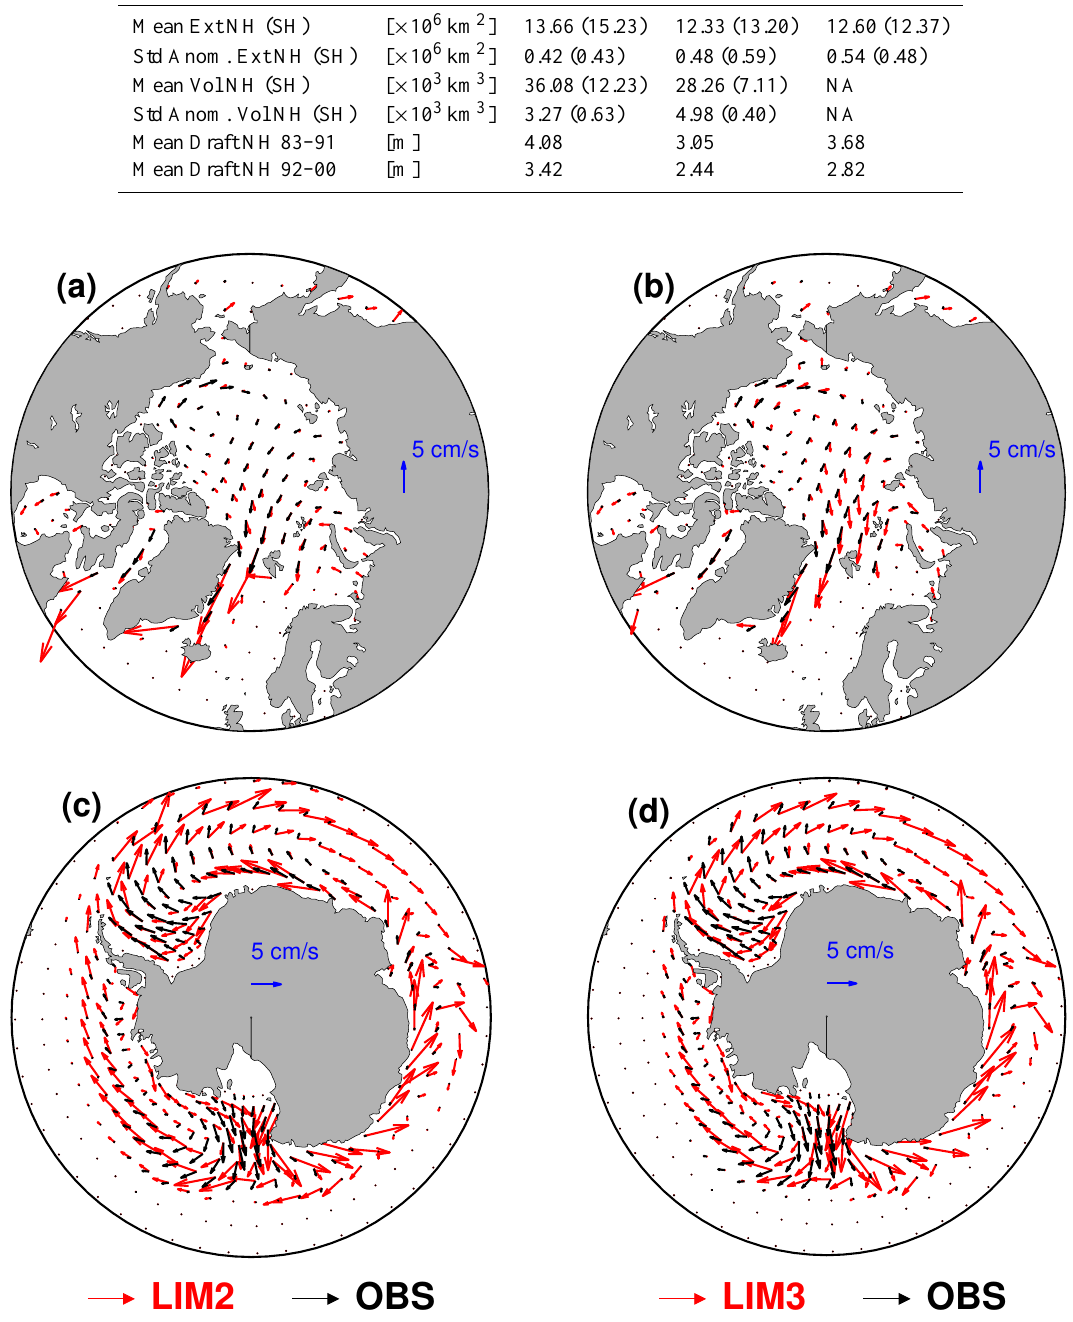
Fig. 4. Simulated and observed mean annual ice drifts (1983–2006), in the Northern Hemisphere ( a and b ) and the Southern Hemisphere ( c and d ). Observations from Fowler (2003, updated 2007) have been interpolated onto the model grid and are depicted with the black arrows. LIM2 ( a and c ) and LIM3 ( b and d ) are represented in red. For readibility, the drift vectors have been plotted every 7 grid